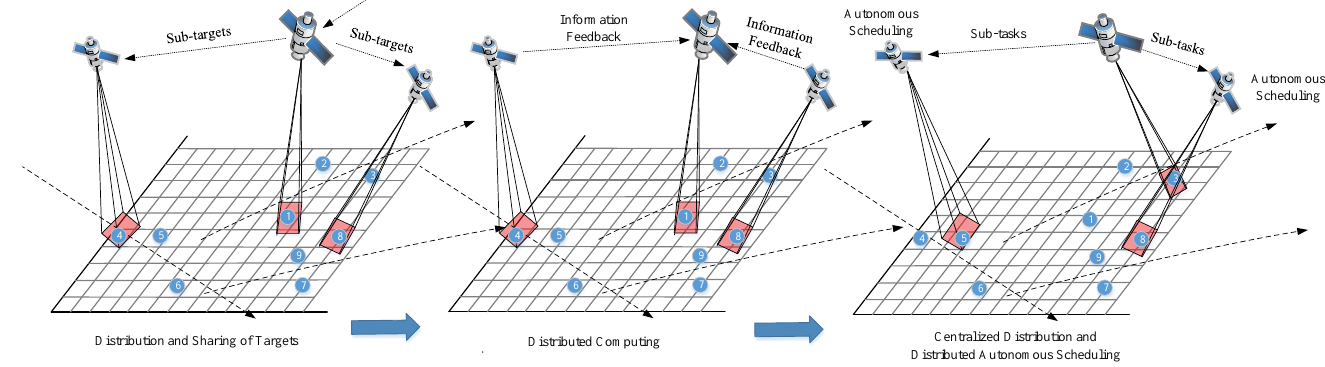
Figure 1. The Multi-satellite collaborative process in centralization-distributed collaborative